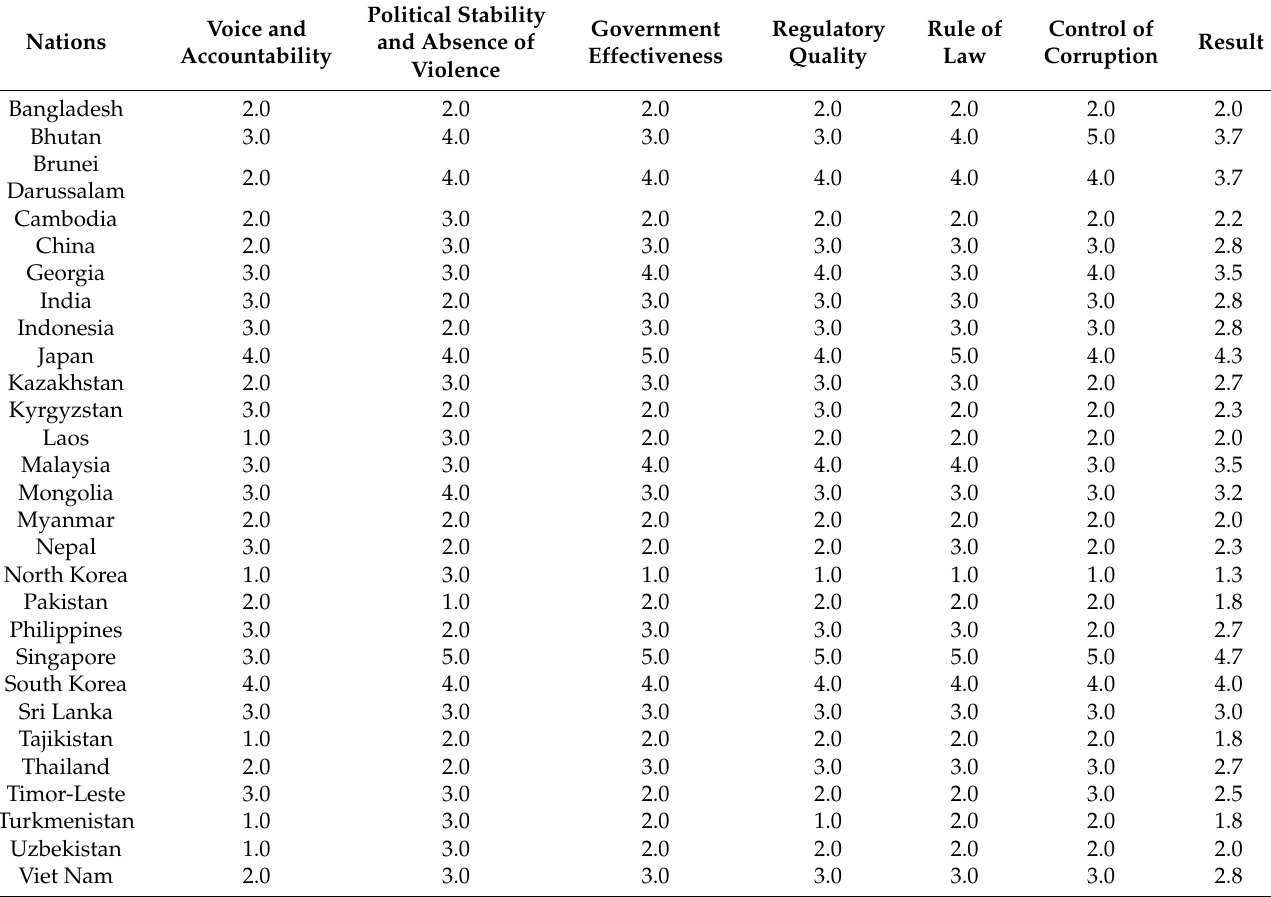
Table 11. Assessment results of government